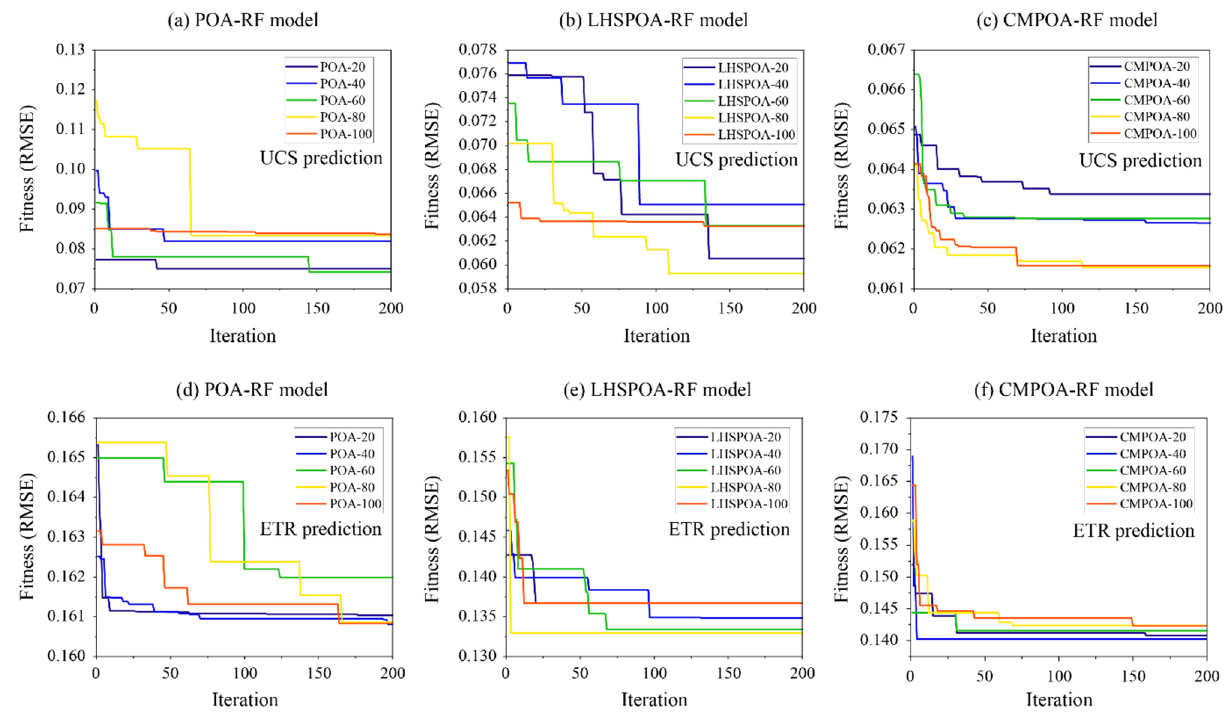
Figure 5. The development results of the proposed models for predicting the UCS and ETR of the novel aseismic concrete material. Table 5. The fitness results of the proposed models based on the different population.